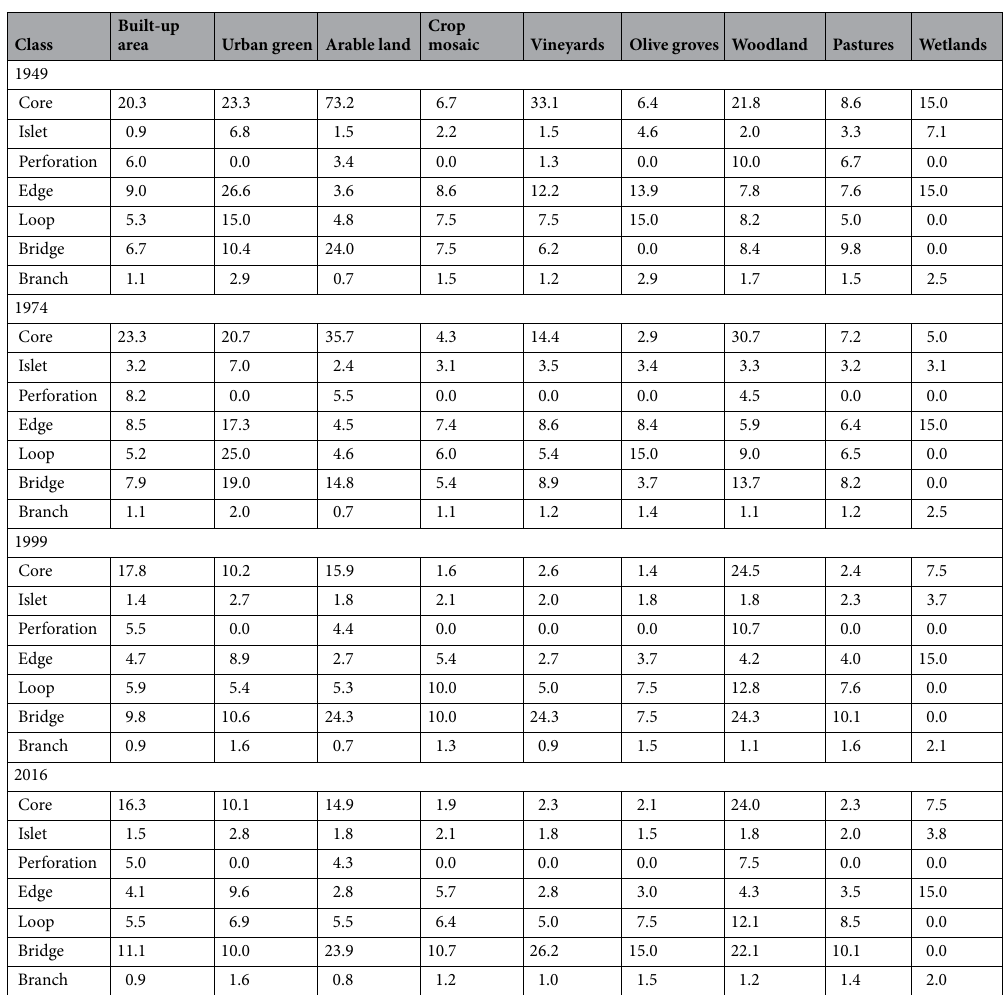
Table 2. Mean patch size (ha) by year and structural (rows)/functional (columns) class in metropolitan